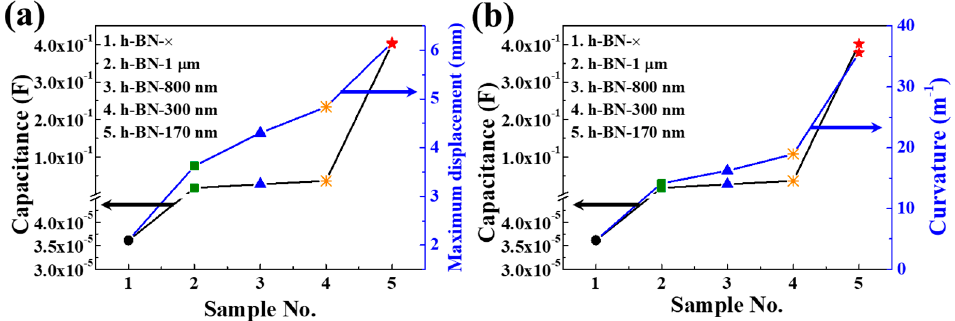
Figure 5. Effect of h-BN layer thickness on capacitance and driving performance of IEAP actuators without insulating layers (h-BN − ×) and with h-BN insulating layers with different particle sizes (1 µ m, 800 nm, 300 nm, and 170 nm): ( a ) Capacitance vs. maximum displacement; ( b ) Capacitance vs.